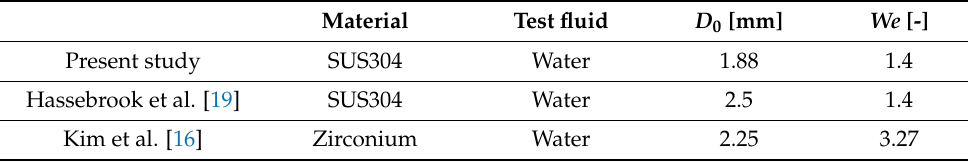
Table 2. Comparison of experimental